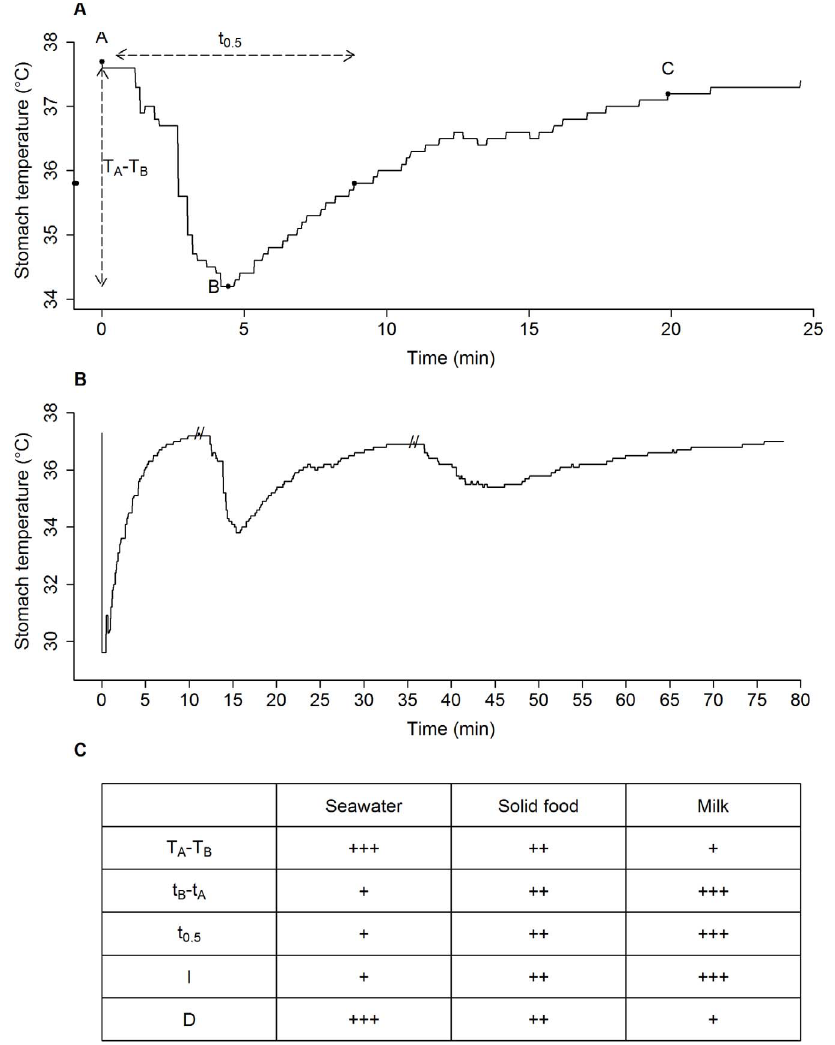
Figure 1. Characteristics of PDERs generated by different ingestion types. A: a PDER event where points A , B and C are showed (see text for definitions), in addition to the amplitude of temperature drop ( T A - T B ), duration from A to half-way temperature recovery ( t 0.5 ) and temperature at half- way temperature recovery ( T 0.5 ), indicated by a black point on the Y axis. B: From left to right; PDER events associated with seawater, solid food and milk ingestions, respectively, extracted from a harbour seal pup stomach temperature record. C: Expected order of magnitude for 6 stomach temperature variables.